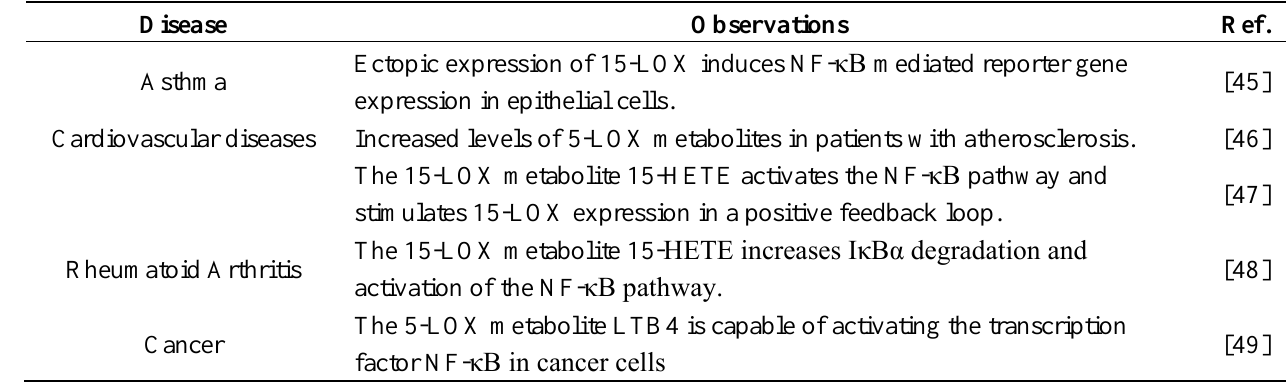
Table 2. Connection between lipoxygenase activity and NF- κB activity in specific diseases. Disease Observations